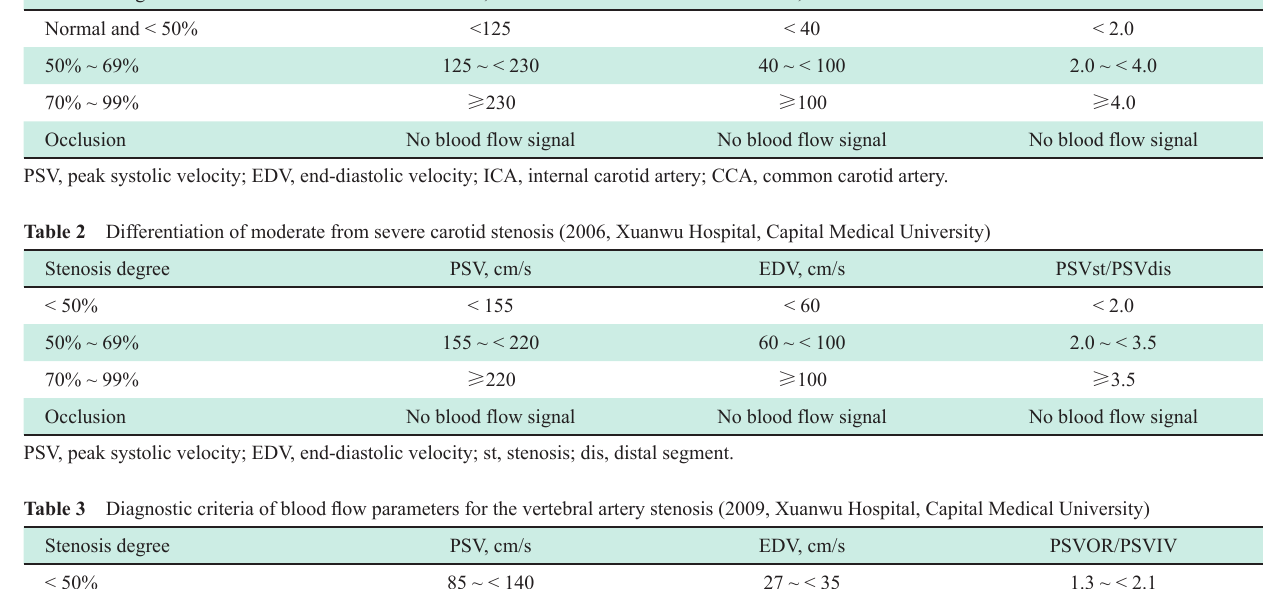
Table 1 Diagnostic criteria of blood flow parameters for internal carotid artery stenosis (2003, North American Radiology Annual Conference) Stenosis degree PSV, cm/s EDV, cm/s PSVICA/PSVCCA Normal and < 50%